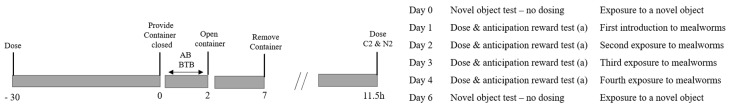
Experimental procedures including the time of dosing (−30 min) prior to the anticipatory test (AT) and behavioral time budget (BTB), subsequent dosing for C2 and N2 treatment hens and the procedures across consecutive days.